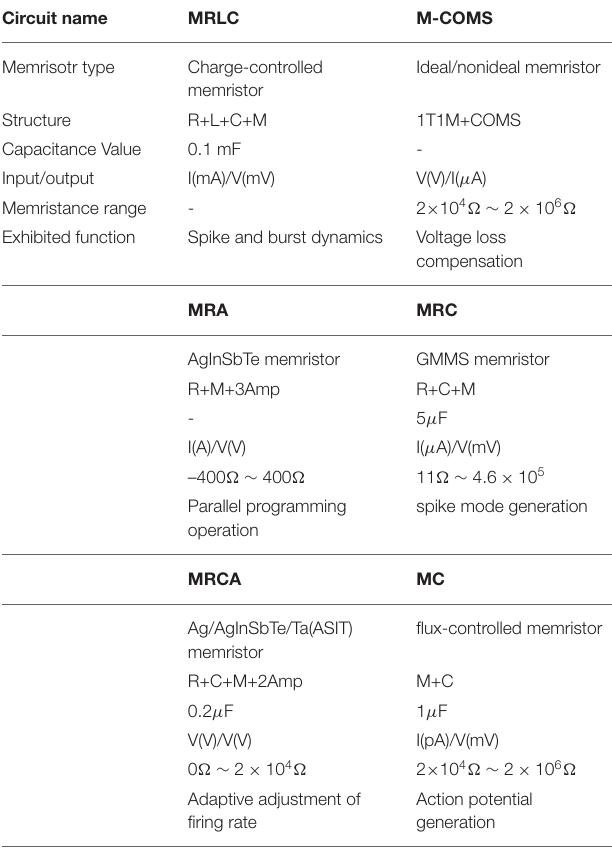
TABLE 1 | The performance comparison between memristive neuron